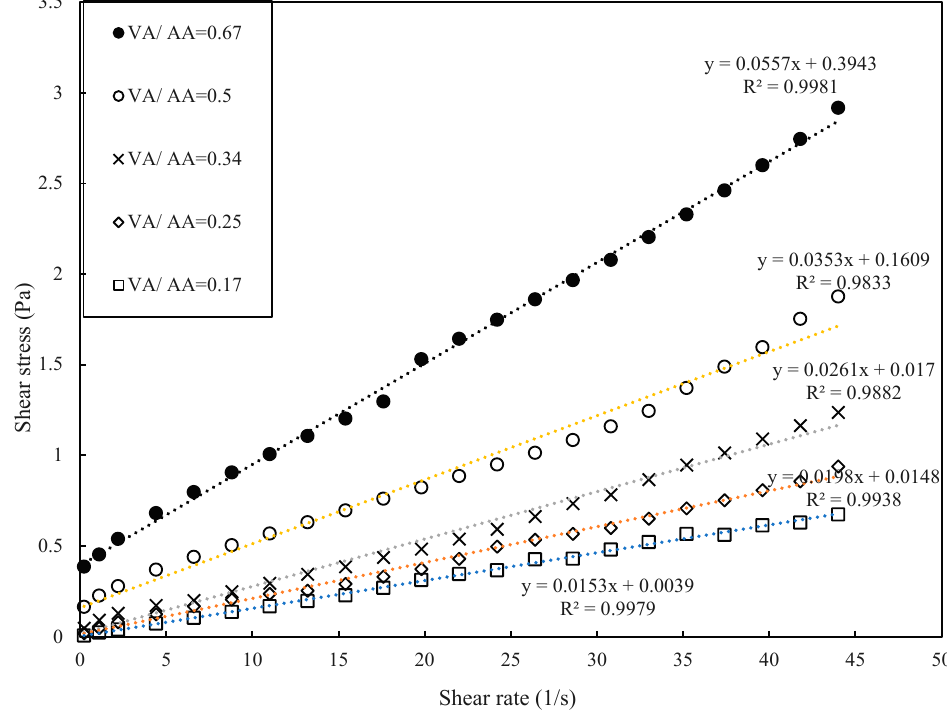
Figure 5. Variations in shear stress with shear rate for different geopolymeric pastes.